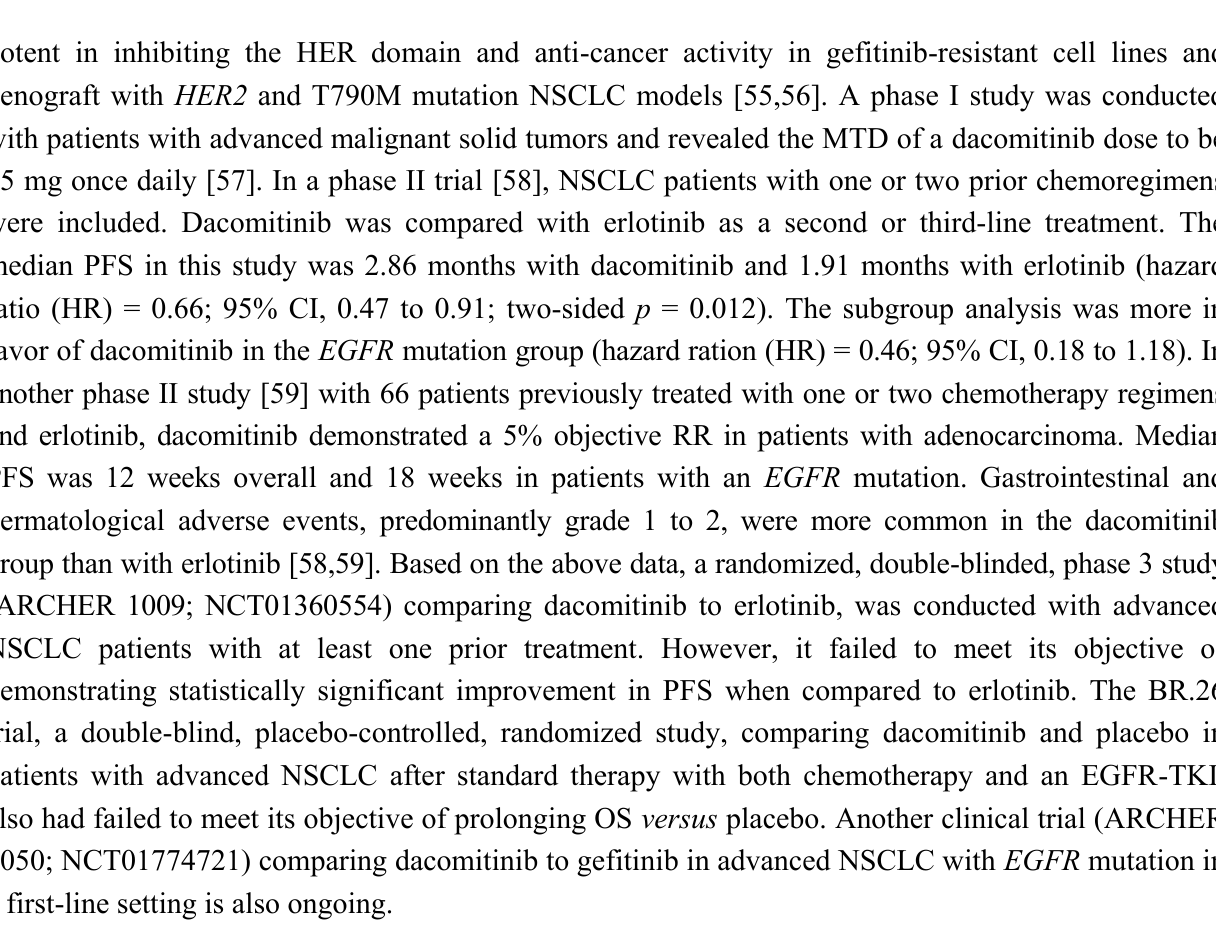
Table 1. The second generation